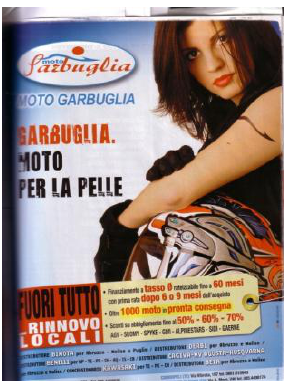
Figure A12. Own selected picture, masculine